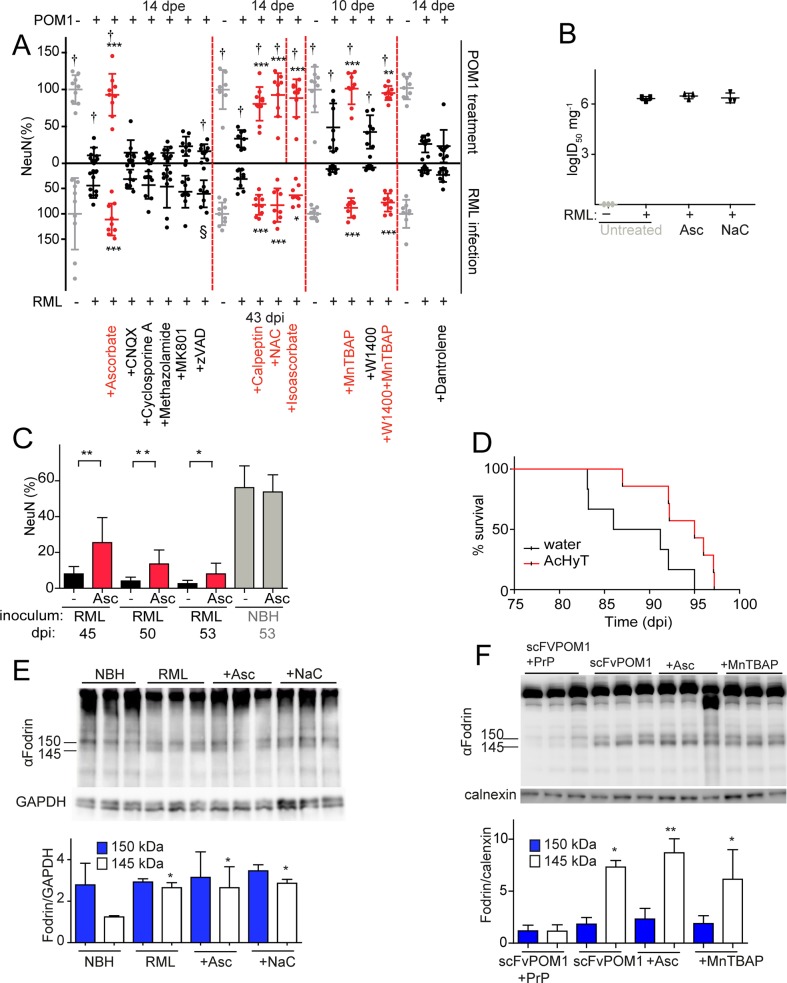
ROS scavengers and calpain inhibitors are beneficial to prion-infected COCS and mice.(A) Lower graph: COCS were inoculated with RML or NBH, cultured for 21 dpi, and then treated with various compounds for 22 days. Upper graph: COCS were cultured for 14 days, incubated with POM1 and treated with the same compounds for 10–14 days. Viability (NeuN) was normalized to COCS exposed to IgG and to non-infectious brain homogenate (upper and lower gray dots, respectively). Calpain inhibitors (Calpeptin), antioxidants (Ascorbate, Isoascorbate, NaC), and superoxide dismutase mimetics (MnTBAP) were neuroprotective in both paradigms (red dots), whereas inhibition of AMPA, kainate receptors (CNQX), NMDA receptors (MK801), a mitochondrial membrane permeability transition pore (methazolamide), caspases (ZVAD), and of ER calcium stores (Dantrolene), (black dots) was ineffective; n = 9 biological replicates. The effects of compounds labeled with “†” on POM1-exposed COCS and zVAD labeled with “§” on RML-infected COCS were reported previously [15], [13] and are reproduced here for convenience. (B) COCS were exposed to NBH (-) or to RML (+) as in (A), and harvested at 39 dpi (n = 3). Prion titers were determined by SCEPA. No reduction in prion infectivity was observed in COCS treated with ascorbate (Asc) or NaC (n = 3 biological replicates). (C) Prion-infected COCS were treated with Asc. Protection was discernible for ≥53 dpi (red bars). Data were analyzed using a two-tailed t-test; n = 9 biological replicates. (D) Survival curves of prion-infected tga20 mice treated with AcHyT (median 95dpi) or vehicle (drinking water; median 88.5dpi). AcHyT treatment increased the incubation time of prion-infected mice (p = 0.0287). Results were analyzed using a Mantel-Cox log-rank test; n = 6 untreated mice and n = 7 AcHyT-treated mice. (E) COCS were treated with antioxidants from 21 dpi onwards (n = 3) and harvested at 40 dpi. Cleaved α-fodrin bands (145 and 150 kDa) were quantified and normalized to GAPDH (right). None of the antioxidants suppressed the prion-induced enhancement of α-fodrin cleavage; n = 3 biological replicates. (F) COCS were cultured for 14 days, treated with scFvPOM1 (400nM) or scFvPOM1 preincubated with recombinant PrP (1200nM) in presence of ascorbate, and harvested at 3 dpe. Cleaved α-fodrin bands (145 and 150 kDa) were quantified and normalized to calnexin (right). Ascorbate did not suppress the GDL induced enhancement of α-fodrin cleavage; n = 3 biological replicates.